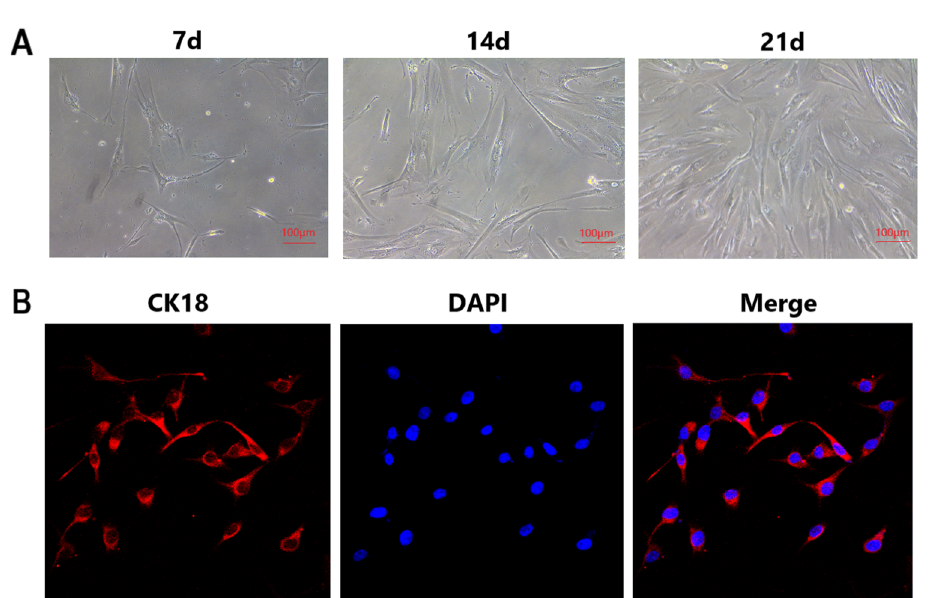
Figure 5. Morphological characteristics and immunocytochemical identification of nasal mucosa epithelial cells. ( A ) Morphological observation of nasal mucosa epithelial cells of mice under inverted microscope. ( B ) Identification of nasal mucosa epithelial cells of mice by immunostaining for CK18 under fluorescence